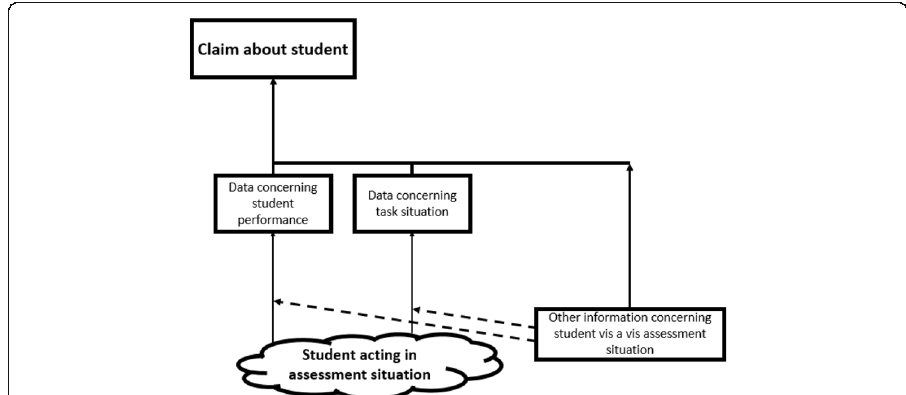
Fig. 3 Selected representation of “ an assessment design argument ” (Mislevy et al. 2015, p. 28). Note: this version of the visual does not include the elements of the descriptive argument as found in the original, please refer to the article cited for the full